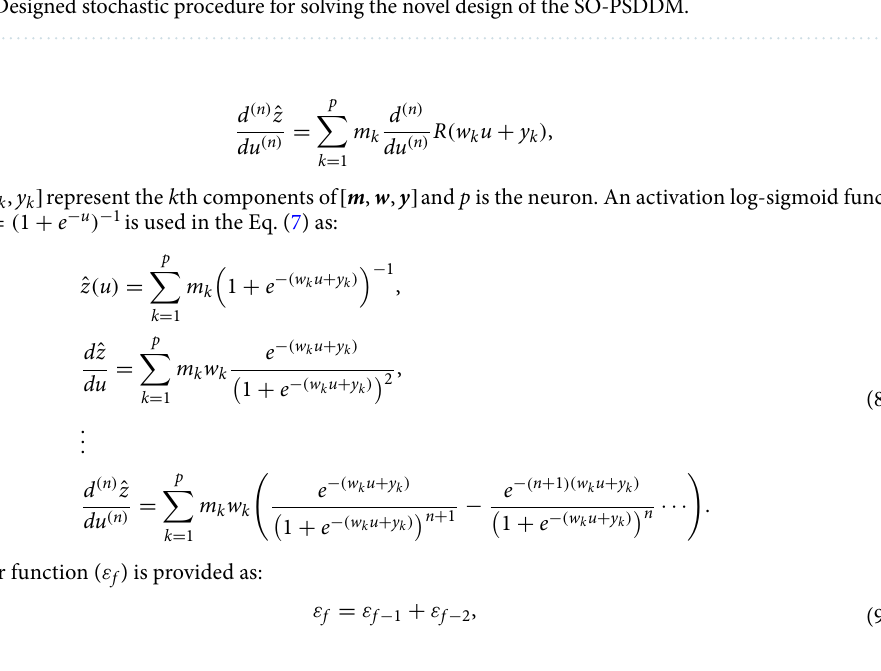
Figure 2. Designed stochastic procedure for solving the novel design of the